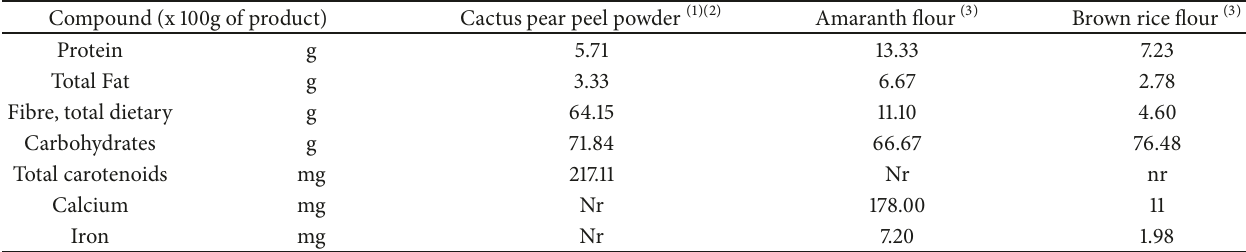
Table 1: Main nutritional compounds of cactus pear peel powder, amaranth flour, and brown rice flour.